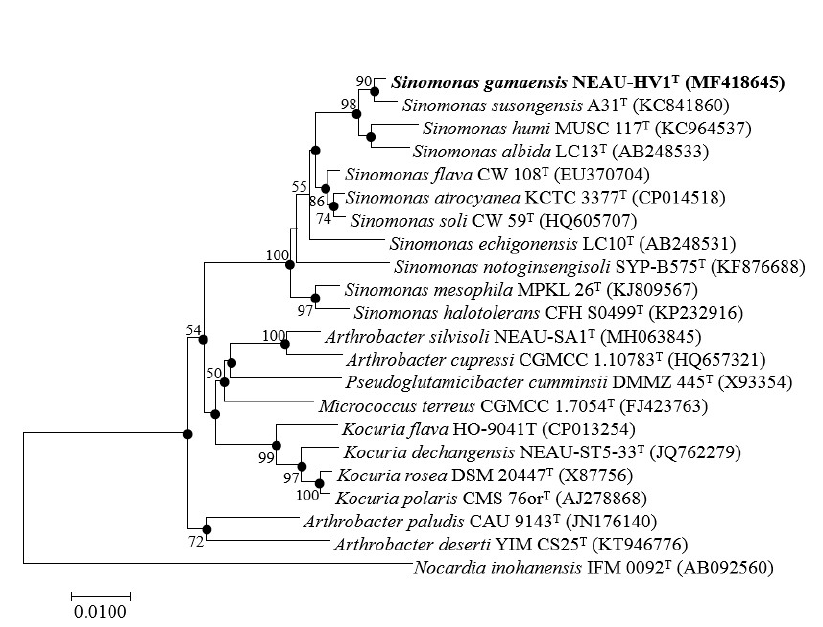
Figure 2. Neighbor joining tree showing the phylogenetic position of strain NEAU-HV1 T (1518 bp) and related taxa based on 16S rRNA gene sequences. Filled circles indicate branches that were also recovered using the maximum-likelihood and minimum evolution methods. Bootstrap values > 50% (based on 1000 replications) are shown at branch points. Bar, 0.01 substitutions per nucleotide position.